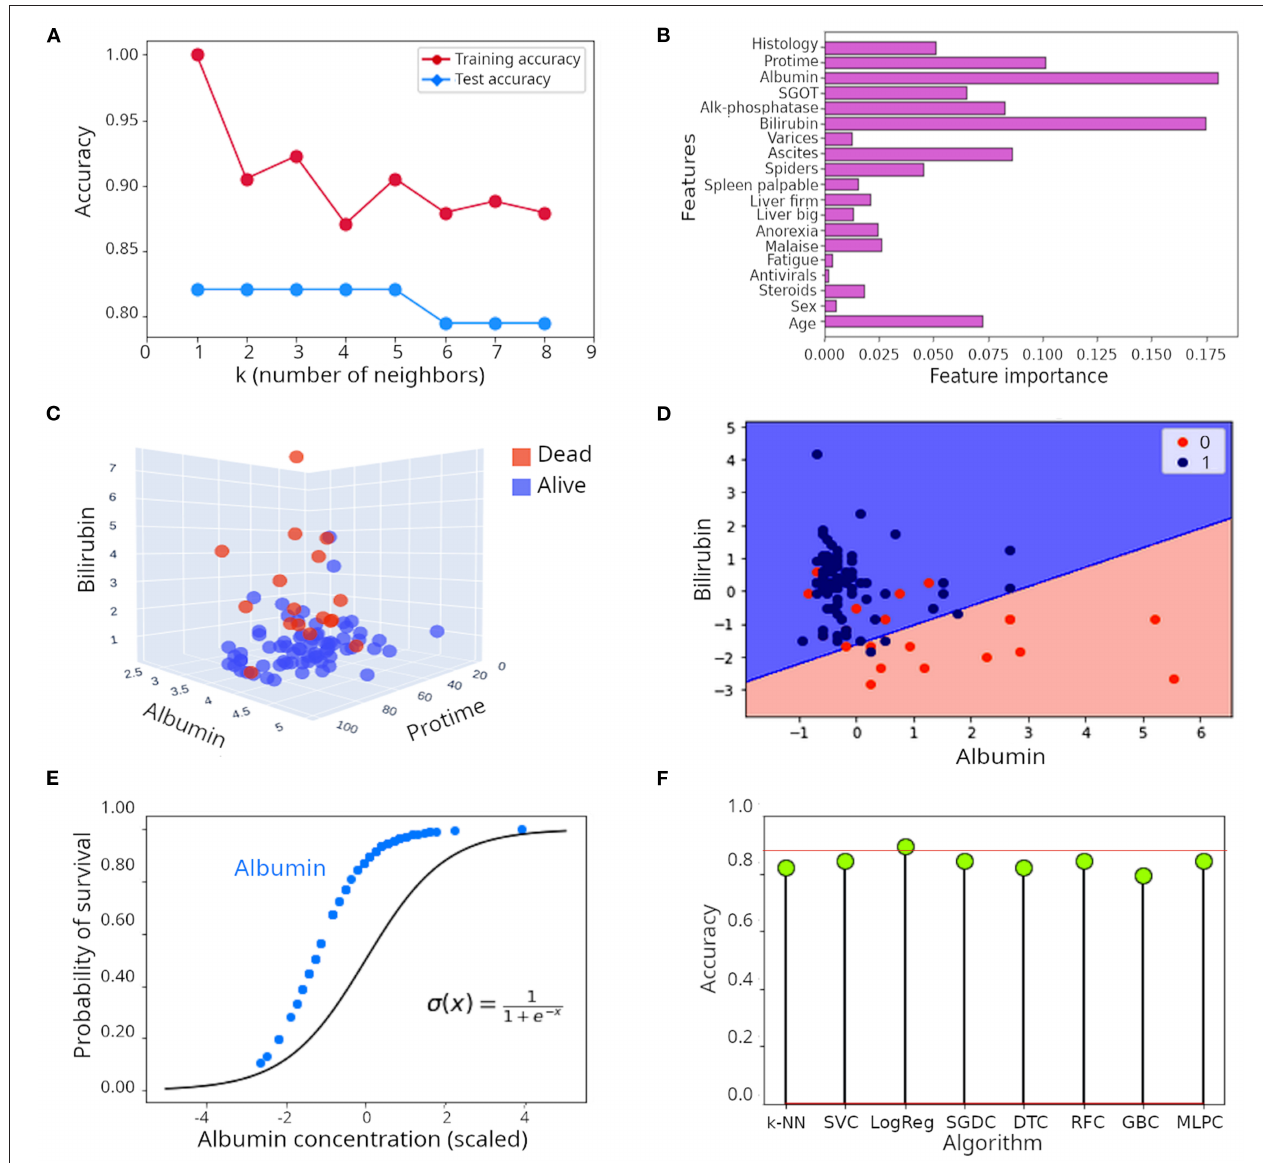
FIGURE 2 | Illustration of supervised learning algorithms. (A) Relationship between number of neighbors (k) and accuracy in the k-NN algorithm when applied to the hepatitis dataset. (B) Feature importance when the random forest algorithm was applied to the hepatitis dataset. (C) Tri-dimensional scatter plot of values of albumin, bilirubin and protime in patients included in the hepatitis dataset. (D) Decision surface of the logistic regression model applied to the hepatitis dataset illustrated in a two dimensional plot including only albumin and bilirubin. (E) Comparison of the theoretical probability distribution of a logistic regression model with the probability distribution of survival of patients in the hepatitis dataset when only albumin is considered as regressor. (F) Lollipop plot of accuracy achieved during classification of survival in the hepatitis dataset. k-NN, k nearest network; SVC, Support vector classifier; LogReg, Logistic regression (R squared); SGDC, Stochastic gradient descent classifier; DTC, Decision tree classifier; RFC, Random forest classifier; GBC, Gradient boosting classifier; MLPC, Multilayer perceptron